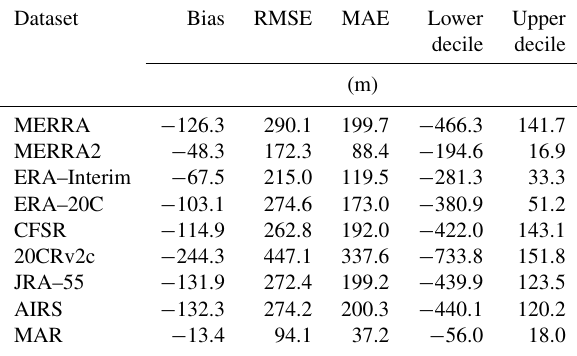
Table 2. Error statistics of model elevation fields (interpolated to EASE grid, except for MAR) relative to the digital elevation model (DEM) of Bamber et al. (2013). Bias and deciles are calculated as (model minus DEM). Averages are taken over all ice sheet grid points, classified using the mask of Bamber et al.